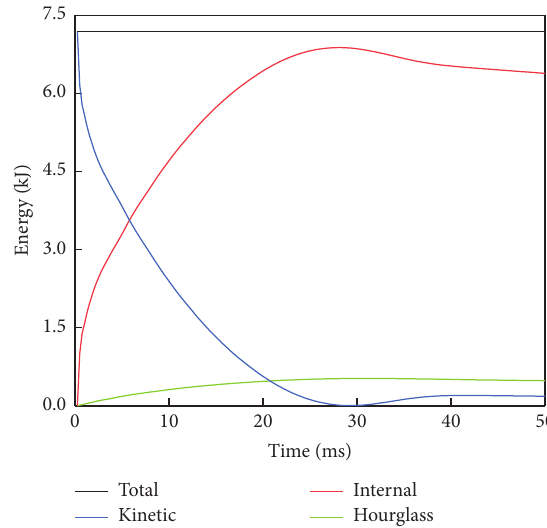
Figure 7: Variation of various energies in a typical impact simulation.